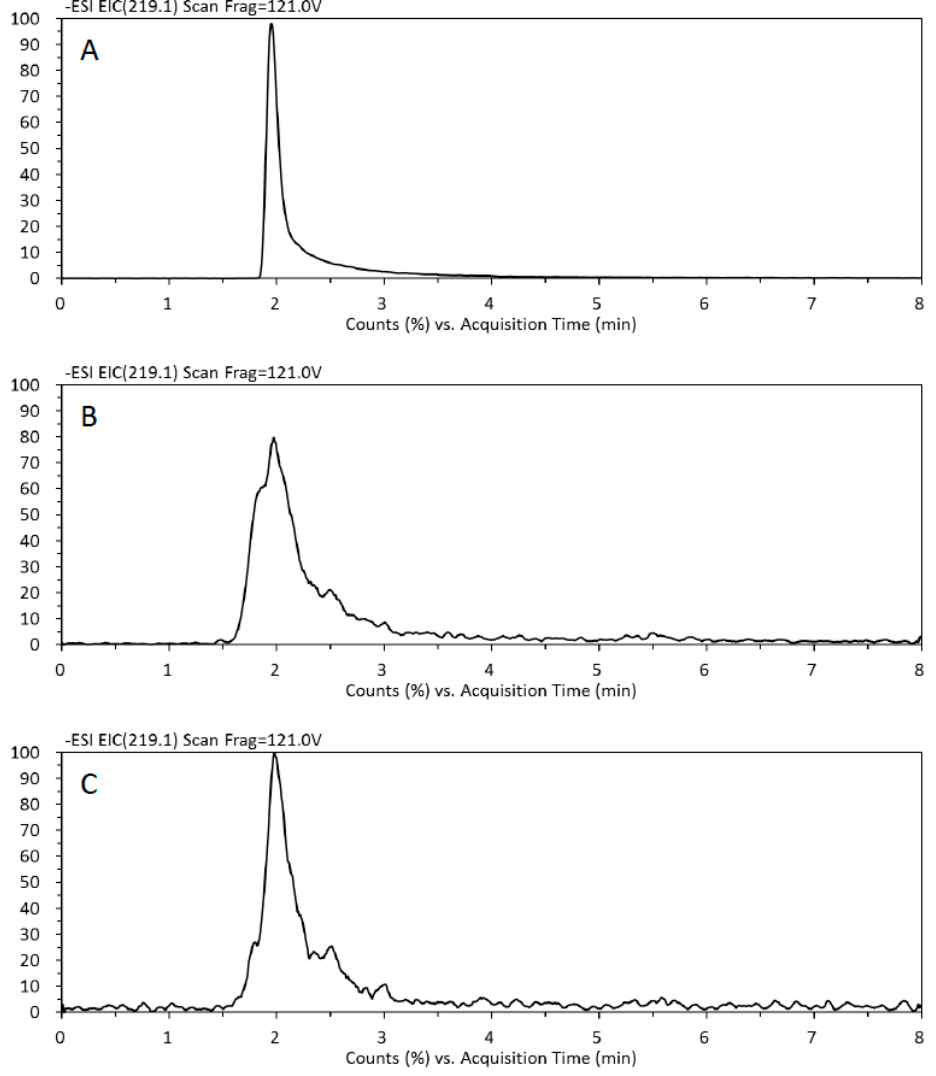
Figure 2. Tandem mass spectrometry (MS2) chromatograms of the purpurogallin (PPG) standard and the solid-phase extraction (SPE) eluents. ( A ) The PPG standard (1 mg/mL in acetonitrile [AN]), ( B ) the coffee eluent extracted with acetonitrile extraction (ANE) and eluted with 100% AN as